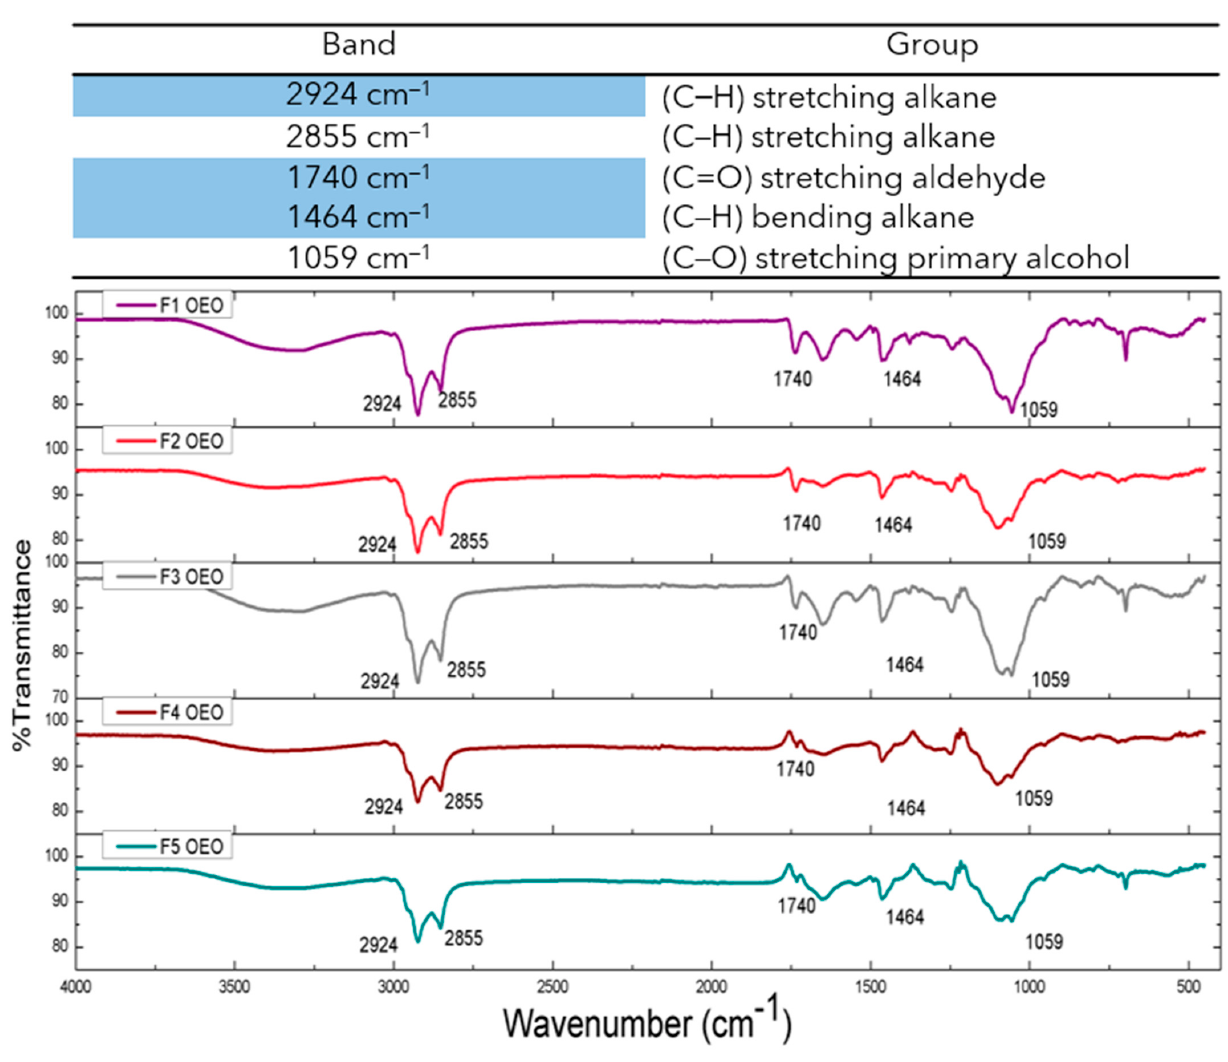
Figure 4. Infrared spectra of five formulations of OEO nanoliposomes at different concentrations (6.2, 4.9, 3.7, 2.5 and 1.2 mM).